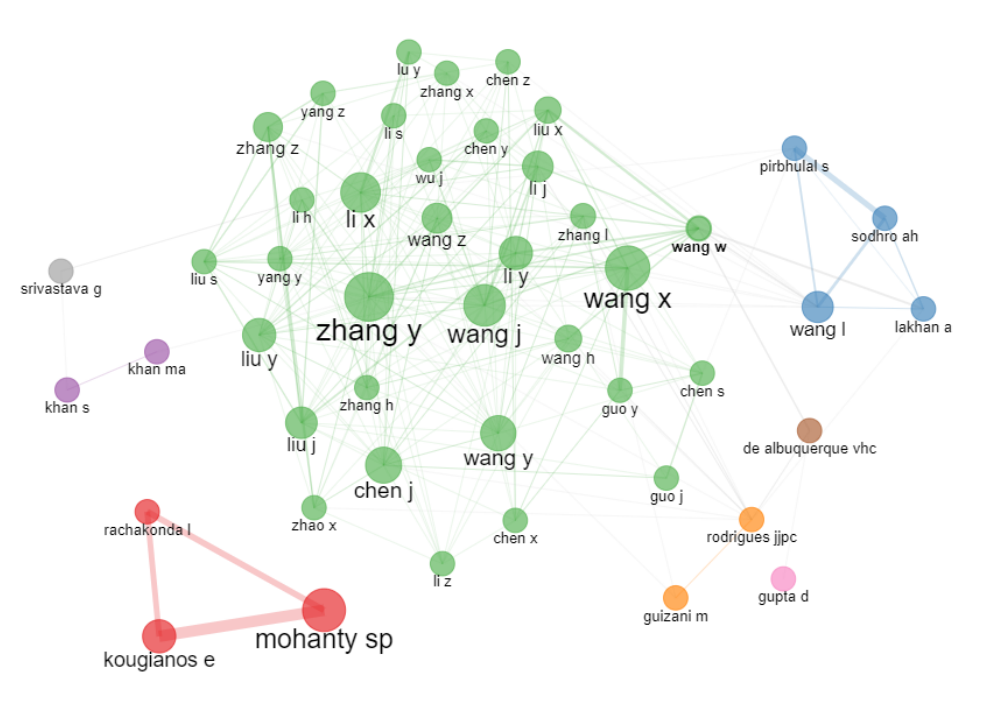
Figure 15. Co-authorship network using the bibliometric R